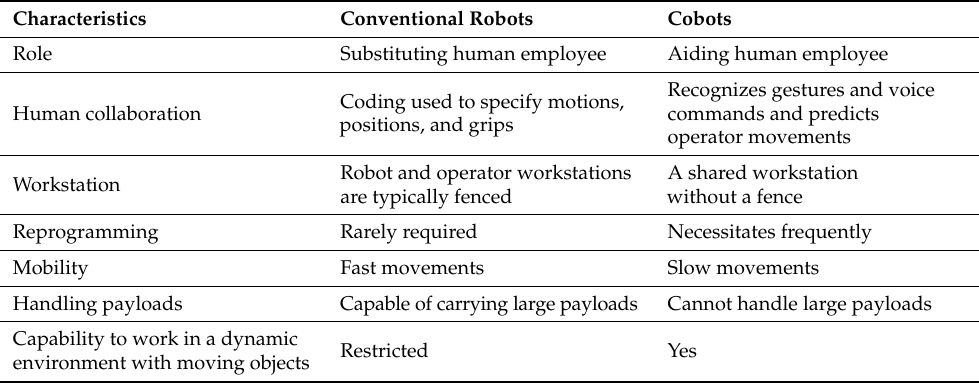
Table 1. Key distinctions between conventional robots and cobots